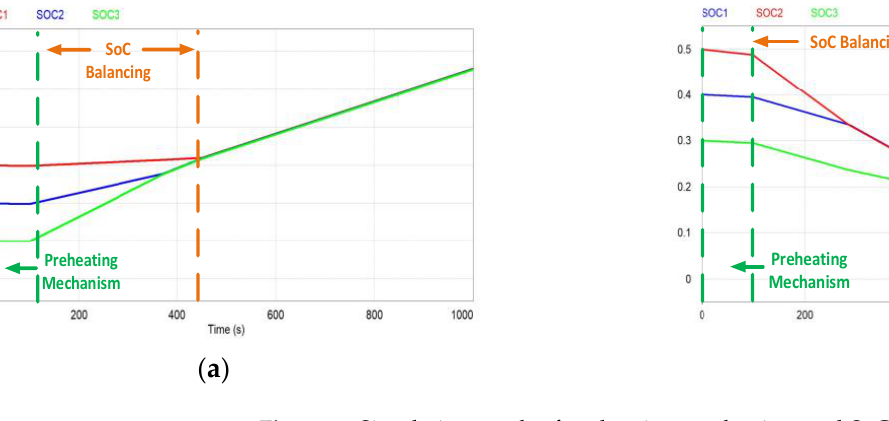
Figure 6. Simulation result of preheating mechanism and SoC balancing for ( a ) charging; ( b ) dis- charging conditions.